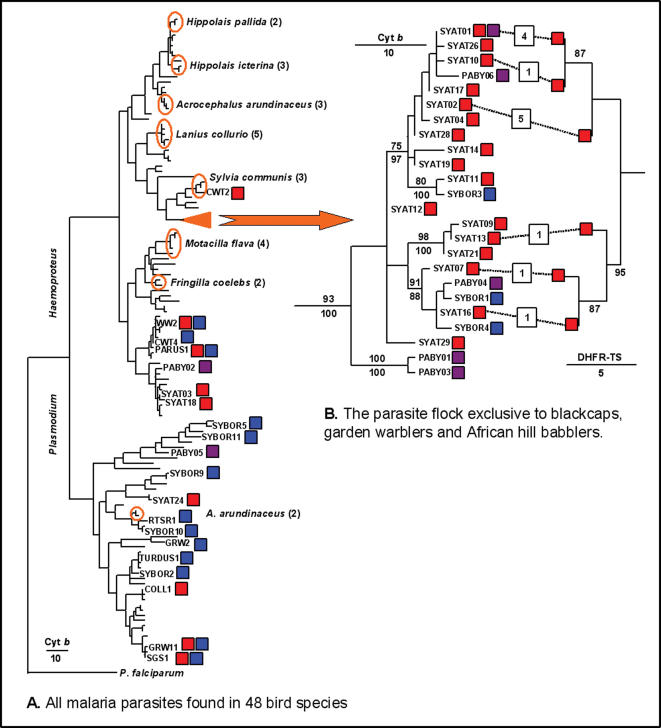
The blackcap parasite flock placed in a phylogenetic context. The tree A shows the phylogenetic position of parasites found in blackcaps (red), garden warblers (blue) and African hill babblers (purple), among 143 parasite lineages found in 48 bird species. Monophyletic parasite groups apparently exclusive to some species are encircled in orange (species names are mentioned and the number of parasites in each group is shown in brackets). The tree B shows the parasite flock (represented by a triangle in the tree A). Numbers represent >75% support to internal branches, based on bootstrap replicates (above) or posterior probabilities (below). For six parasites in this cluster, the figure shows the match between phylogenies based on mitochondrial cytochrome b and nuclear DHFR-TS genes (the number of cases with each association of haplotypes is indicated, and bootstrap support is reported if >75%).